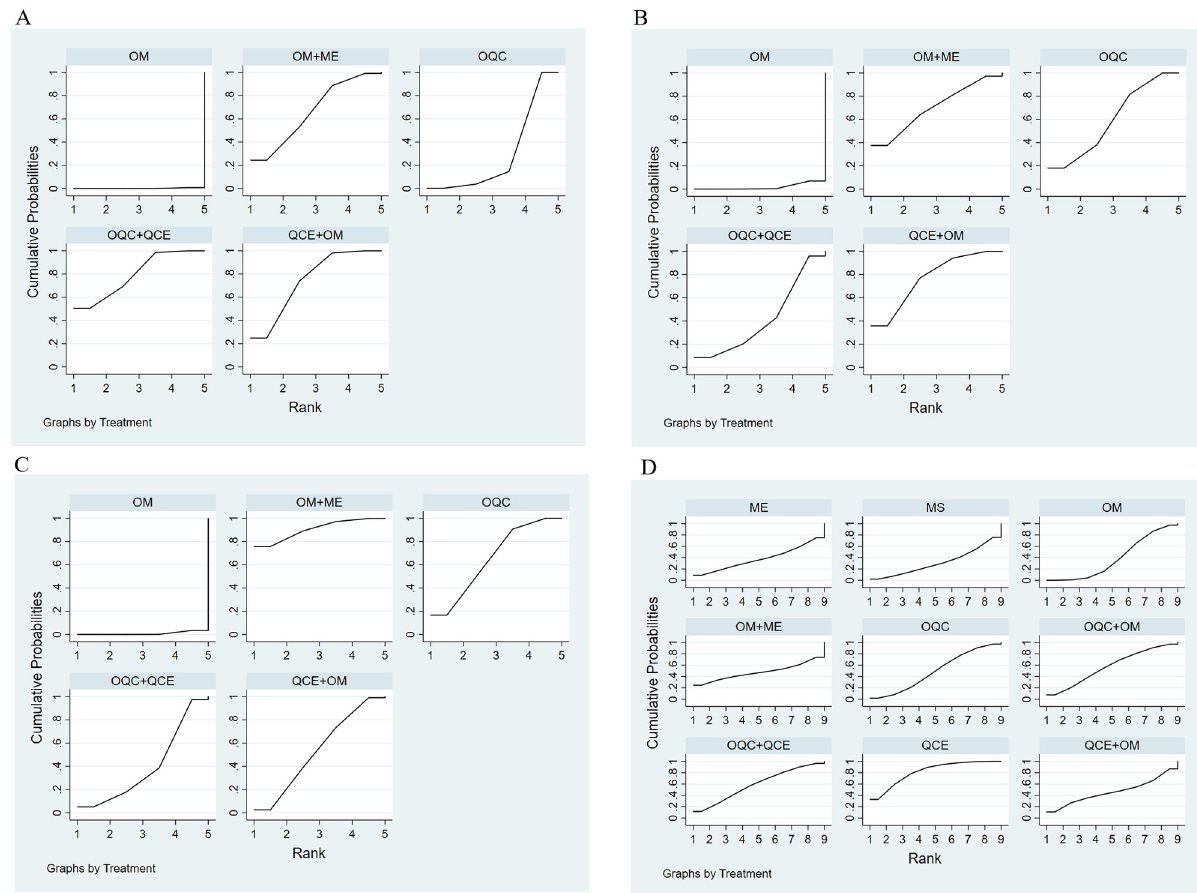
Fig 9. Surface under the cumulative raking curve of TCM syndrome and integral. (a) Abdominal pain; (b) bloody stool; (c) diarrhea; (d) adverse effects.